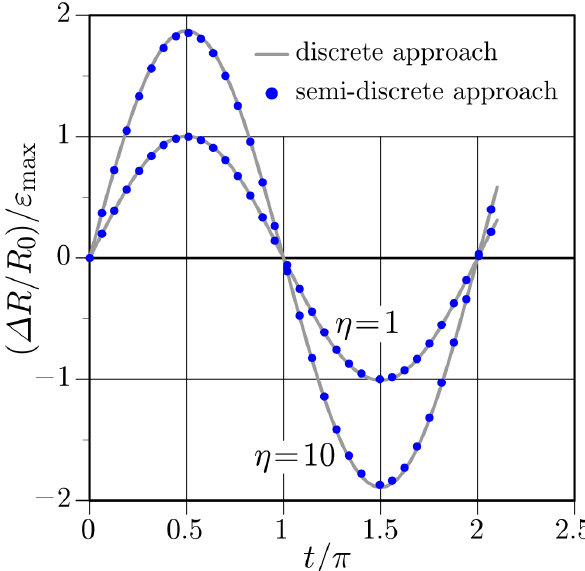
Figure 11. Change in resistance of the numerical specimen under sinusoidal mechanical